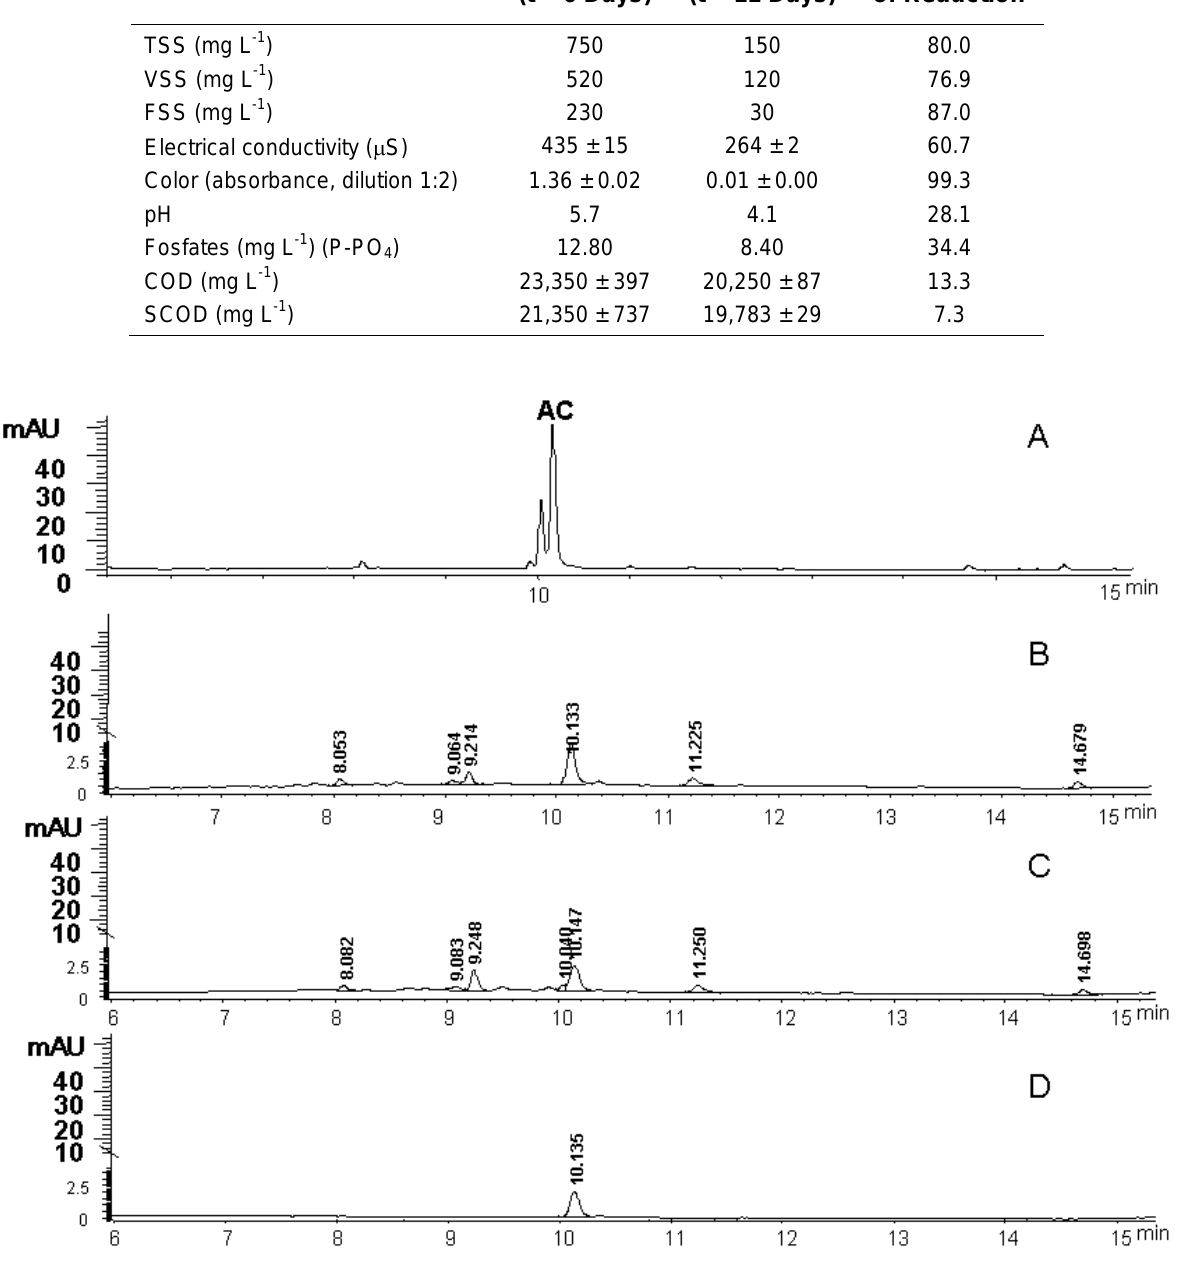
FIGURE 3. Chromatograms for treatments. (A) Initial, and after an 11-day period for treatments (B) 5, (C) 7, and (D) 8. AC = carminic